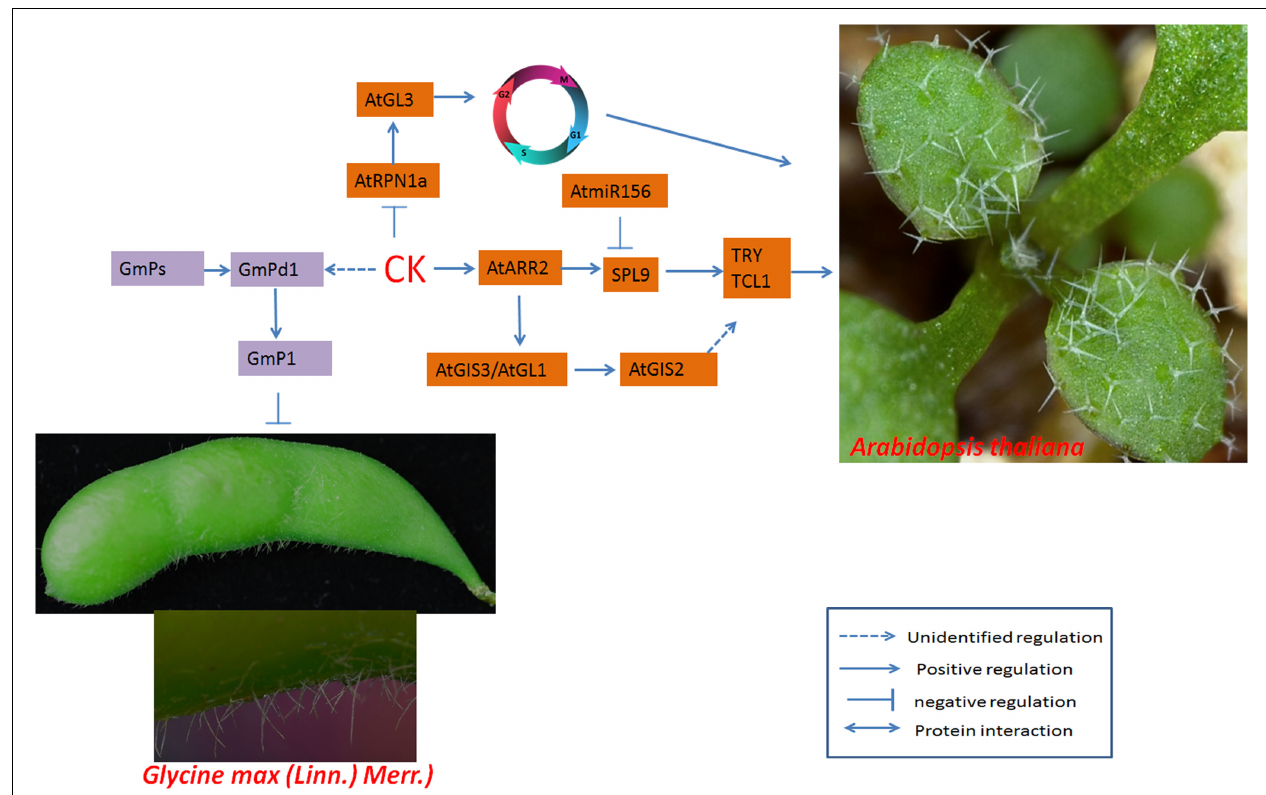
FIGURE 6 | Regulatory networks of cotton fiber and trichome development induced by CKs. The CK receptor AtARR2 interacts with AaSPL9, which is involved in trichome development in Arabidopsis. In soybean, the expression of GmPd1 is induced by CKs, and GmPd1 binds directly to the promoter of GmP1 (which encodes a lipid transporter) and promotes trichome development. ARR, nuclear-localized B-type ARABIDOPSIS RESPONSE REGULATOR.